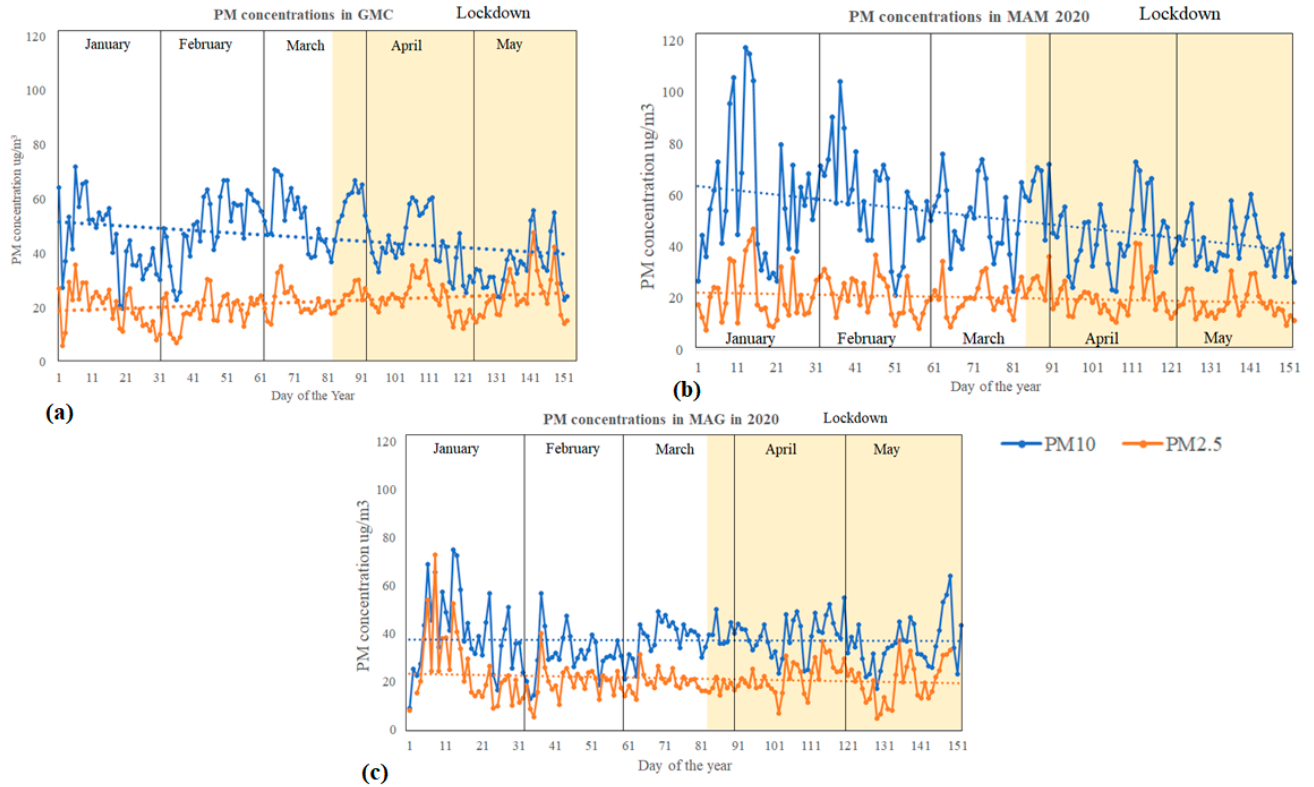
Figure 4. PM concentrations at ( a ) GMC, ( b ) MTY, and ( c ) MAG from 1 January to 31 May 2020. The lockdown period is marked in yellow (from 23 March 2020, DOY 83).